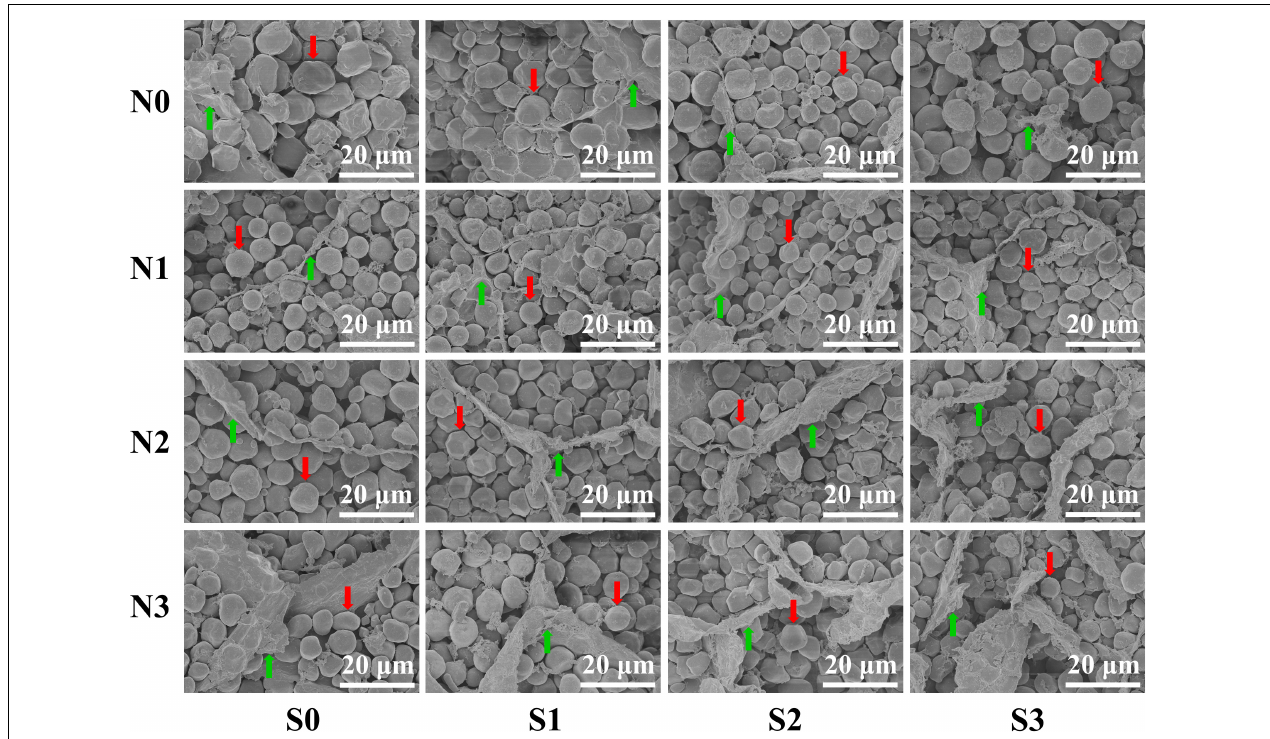
FIGURE 4 | Grain endosperm ultrastructure of maize at different N and S rates. The weight of individual grains was calculated based on the grain weight per hundred kernels of the maize, and the grains equal to the average grain weight were selected by weighing with an electronic balance. The selected samples of maize grains were sliced with a blade (thickness ≈ 1 mm). The prepared samples were observed and photographed using a scanning electron microscope. In this image, the red arrows indicate the starch granules, the green arrows indicate the matrix proteins, and the bars represent 20 µ